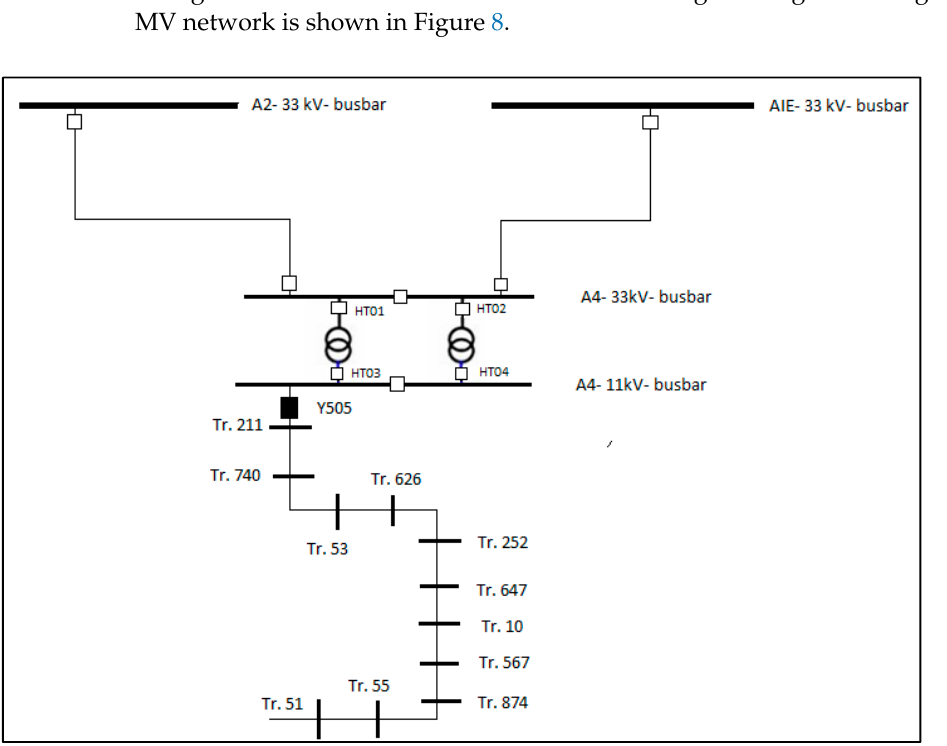
Figure 8. SLD of the distribution network under investigation.